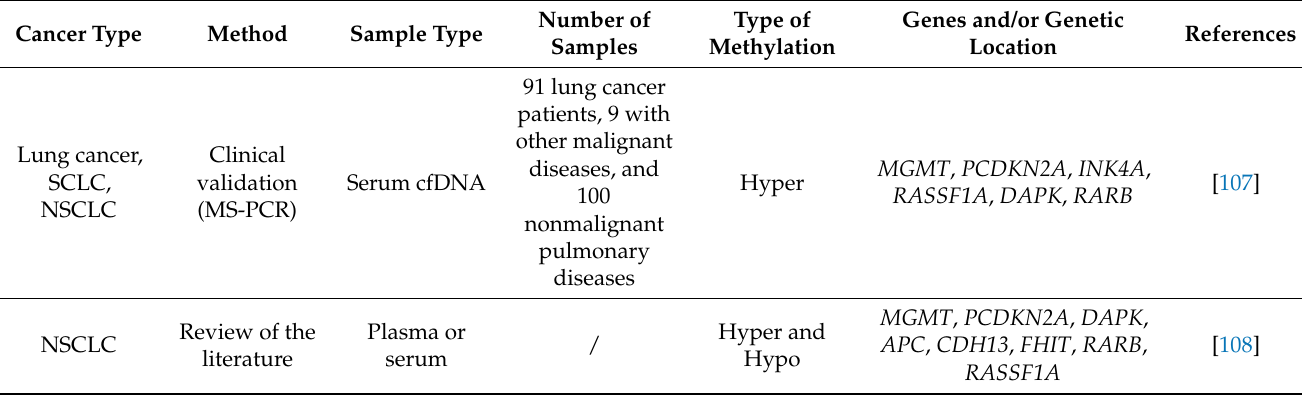
Table 5. An overview of methylation biomarkers for lung cancer in liquid biopsy. NSCLC: non-small cell lung cancer; SCLC: small-cell lung cancer; cfDNA: cell-free DNA; MS-PCR: methylation-specific polymerase chain